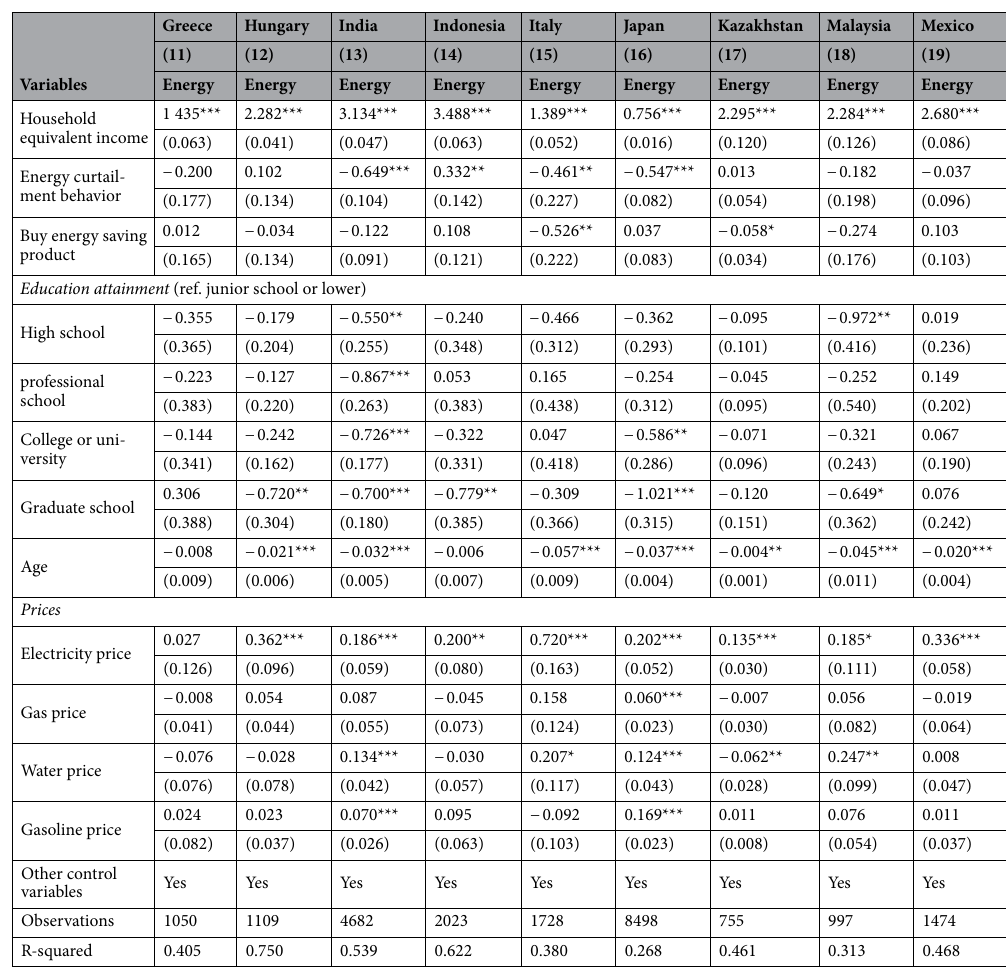
Table 5. Household socioeconomic and demographic determinants of household energy consumption expenditure II. Standard errors in parentheses. *** p < 0.01, ** p < 0.05, * p < 0.1. Other control variables include occupational status, household status, number of children, and gender